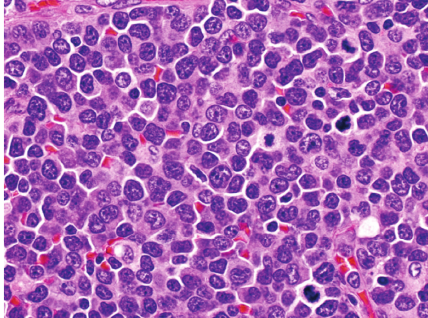
Figure 2: A low power view, displaying a characteristic tumor growth pattern, with pale areas surrounded by darkly staining areas, the latter imparting a starry sky appearance.